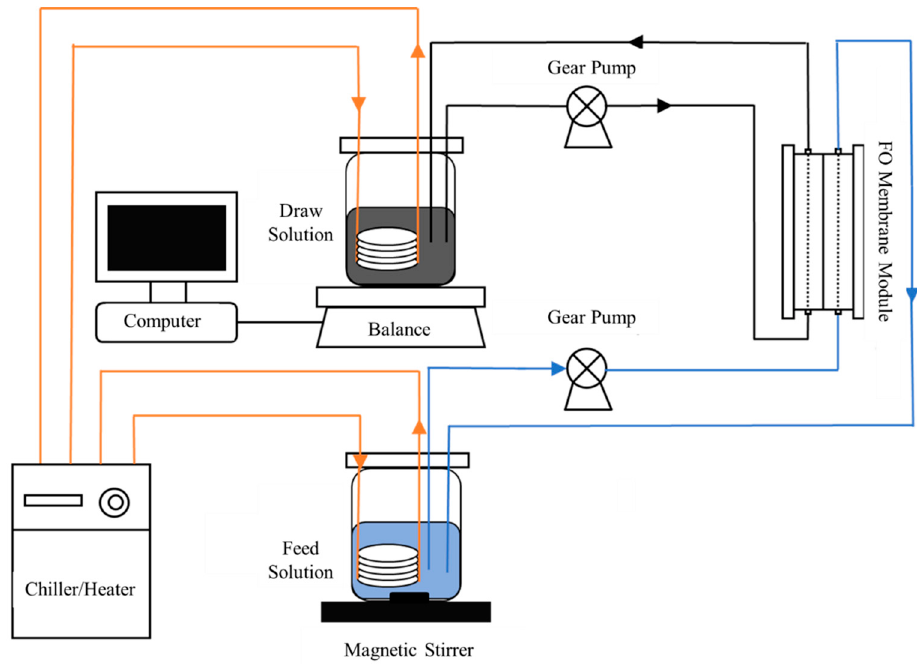
Figure 1. The diagram using forward osmosis membrane technology for biogas slurry concentra- tion.